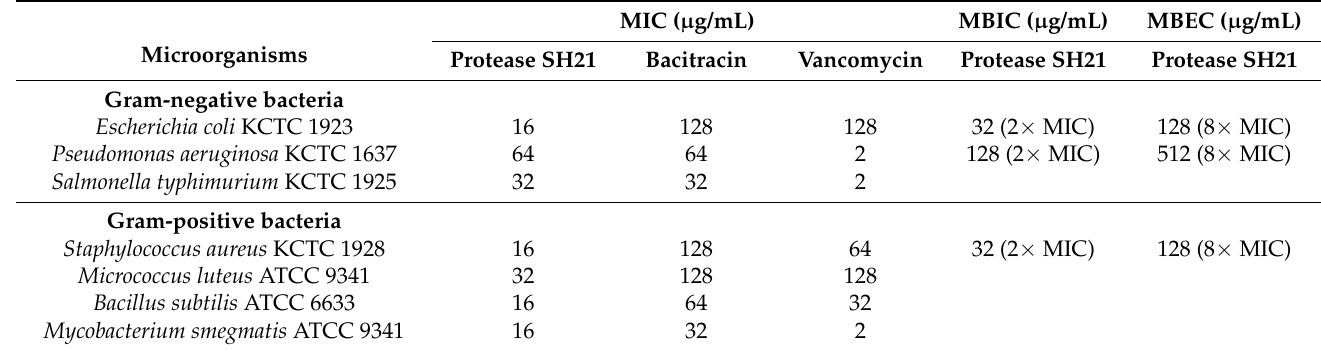
Table 4. Antibacterial (MIC) and antibiofilm (MBIC and MBEC) activity of protease